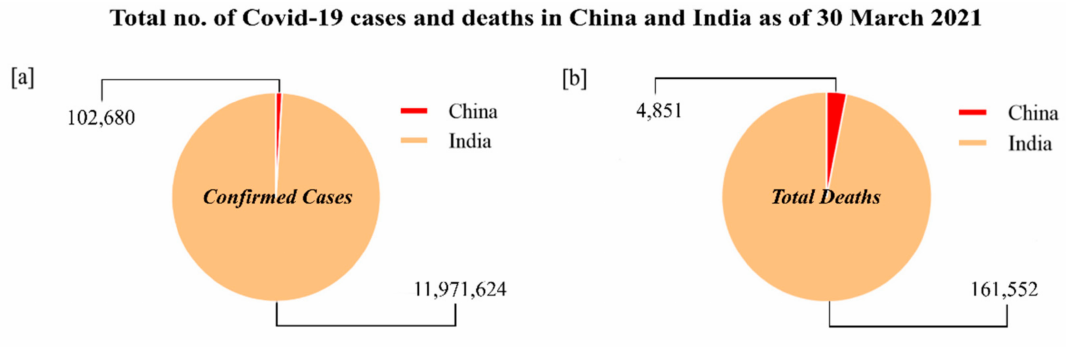
Figure 1. ( a ) COVID-19 confirmed cases and ( b ) deaths in China and India, 30 January 2021 (data adopted from WHO COVID-19